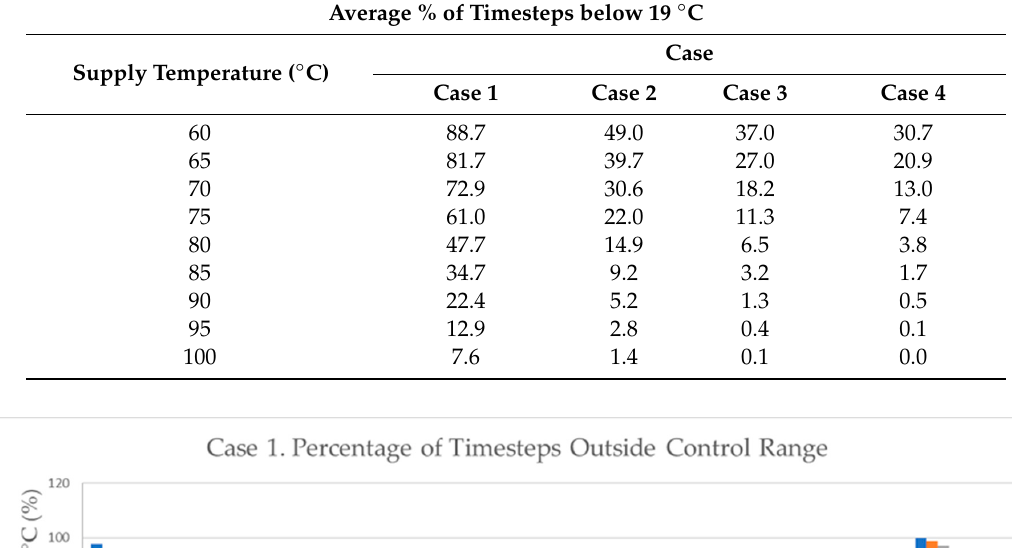
Table 4. Average percent of timesteps below 19 °C across all dwellings.